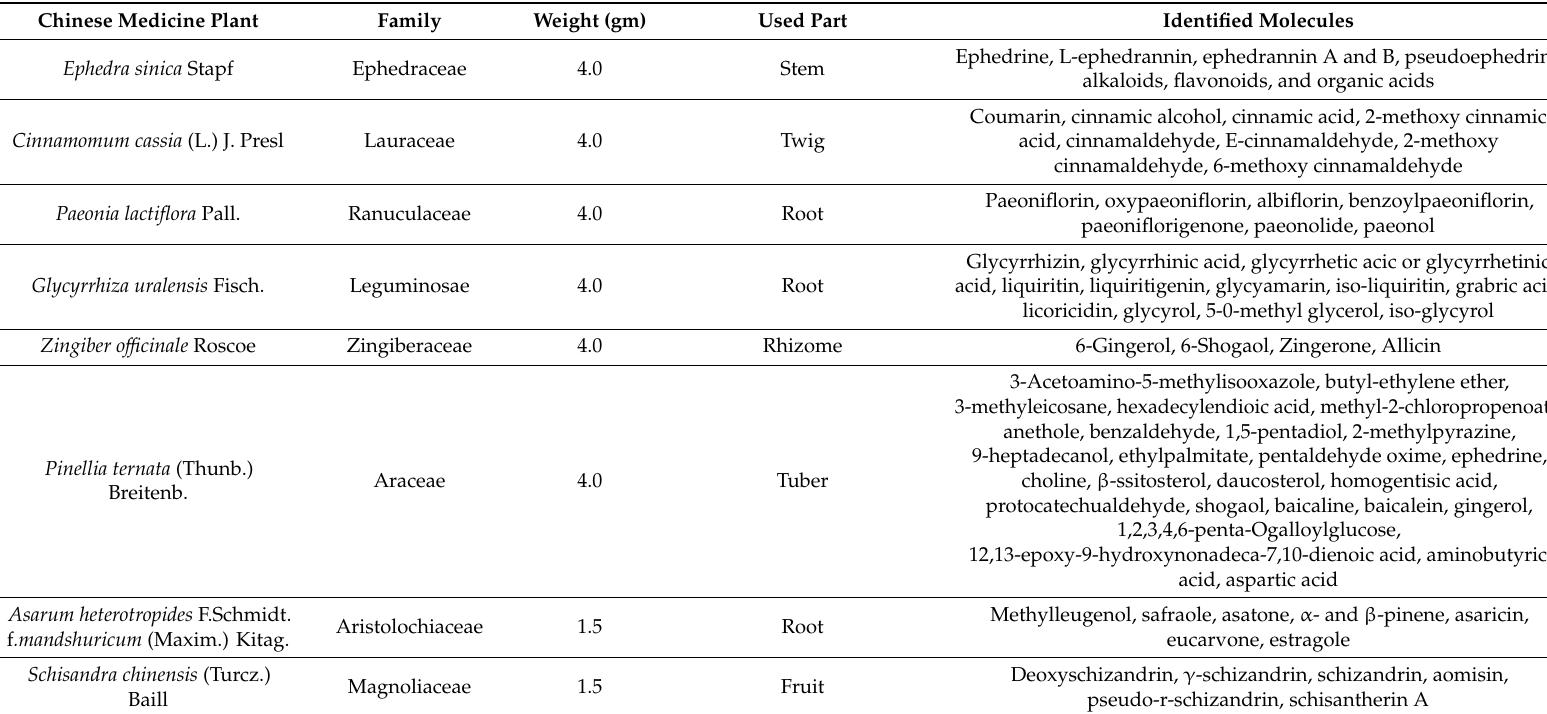
Table 4. Composition Xiao-Qing-Long-Tang (XQLT; Sho-seiryu-to in Japan; so-cheong-ryong-tang in Korea) [98]. Chinese Medicine